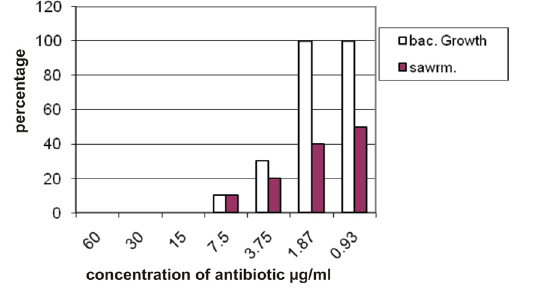
Fig. 3. Effect of amikacin on growth and swarming of Proteus